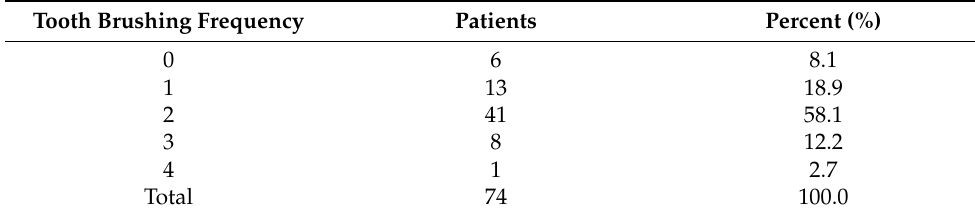
Table 5. Tooth brushing frequency for selected patients.